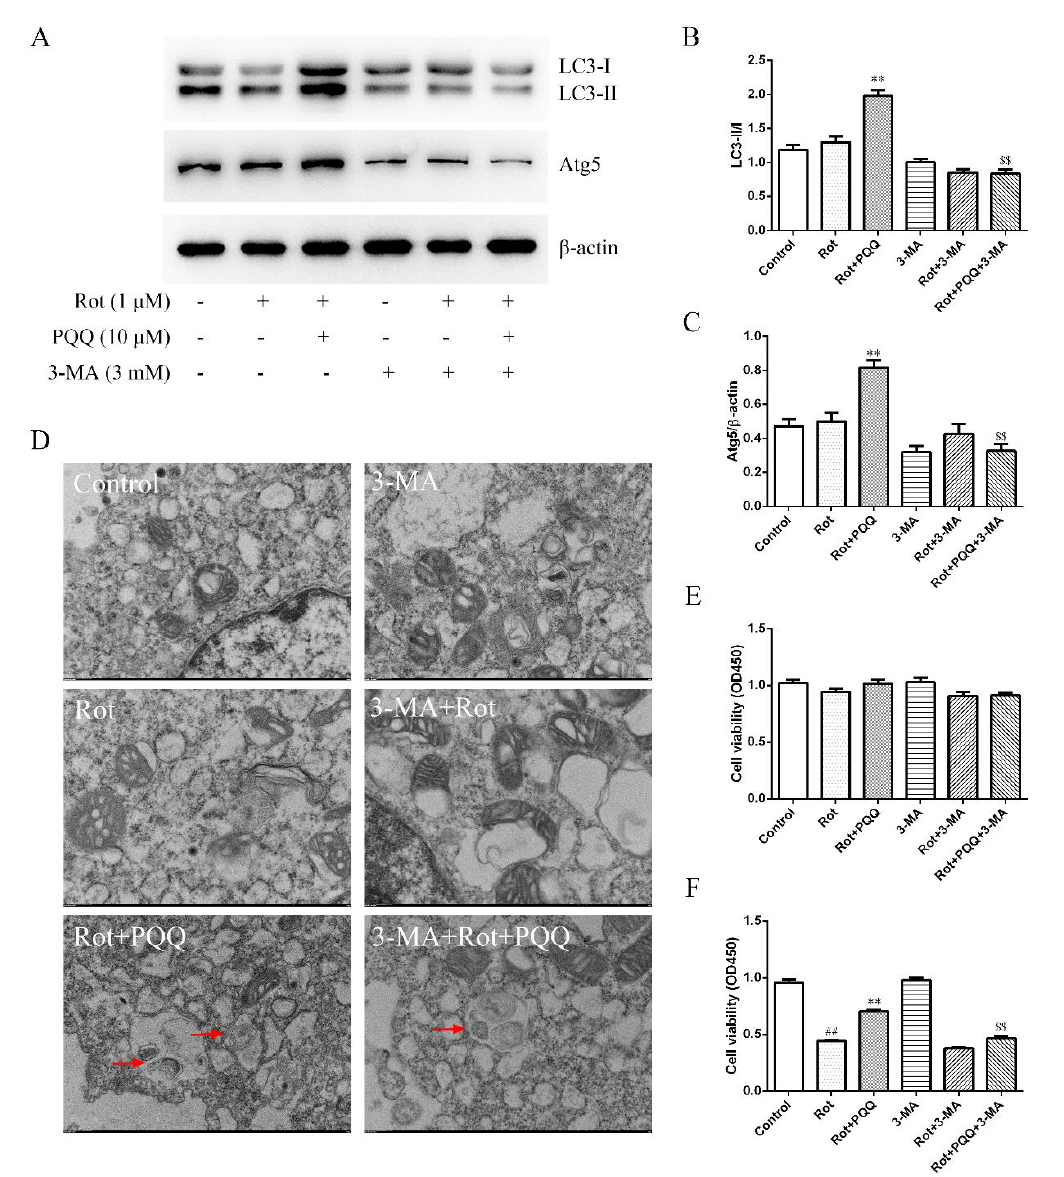
Figure 4. Inhibition of autophagy by 3-methyladenine (3-MA) reversed the protective e ff ect of PQQ on rotenone-induced neurotoxicity. 3-MA was applied to the BV2 cells at the concentration of 3 mM 1 h before 10 µ M PQQ pretreatment and 1 µ M rotenone stimulation for 12 h. ( A ) Representative images of LC3-I / LC3-II and Atg5 expressions detected by Western blotting analysis. β -actin was used as a loading control. Quantification of the ratio of LC3-II / I ( B ) and the relative expression of Atg5 in BV2 cells ( C ). The data were presented as the mean ± SEM from four independent experiments. ( D ) Representative TEM images of BV2 cells with di ff erent treatments as indicated. Arrows indicate autophagic vacuoles. Scale bar = 1 µ M. ( E ) Cell viability of BV2 cells was measured with CCK-8 assay. ( F ) SH-SY5Y cells were incubated with the CM from BV2 cells with di ff erent treatments for 24 h and cell viability was measured with CCK-8 assay. The data were presented as the mean ± SEM from three or four independent experiments. For CCK-8 assay, 10 wells were included in one experiment. ** p < 0.01 vs. rot group; ## p < 0.01 vs. control group; $$ p < 0.01 vs. Rot + PQQ